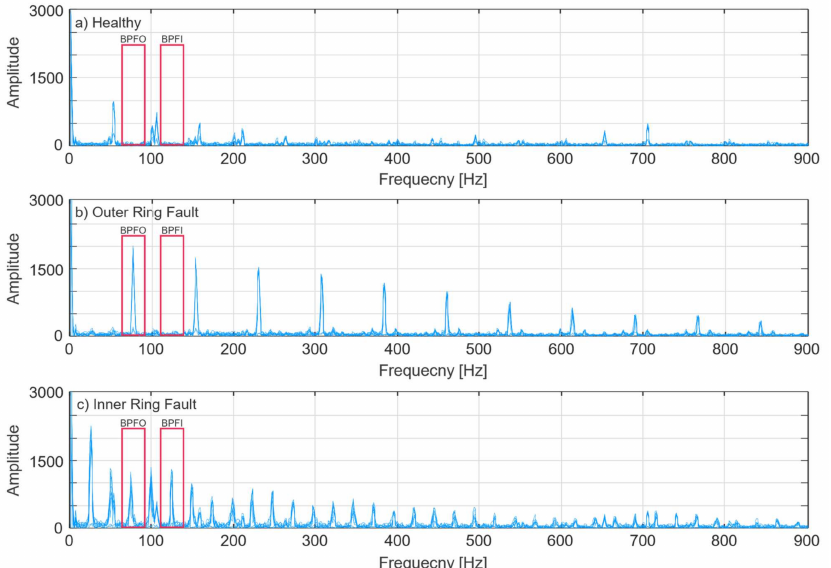
Figure 10. Squared envelope vibration signal spectra of: ( a ) Healthy bearing; ( b ) Bearing with inner ring fault; ( c ) Bearing with outer ring